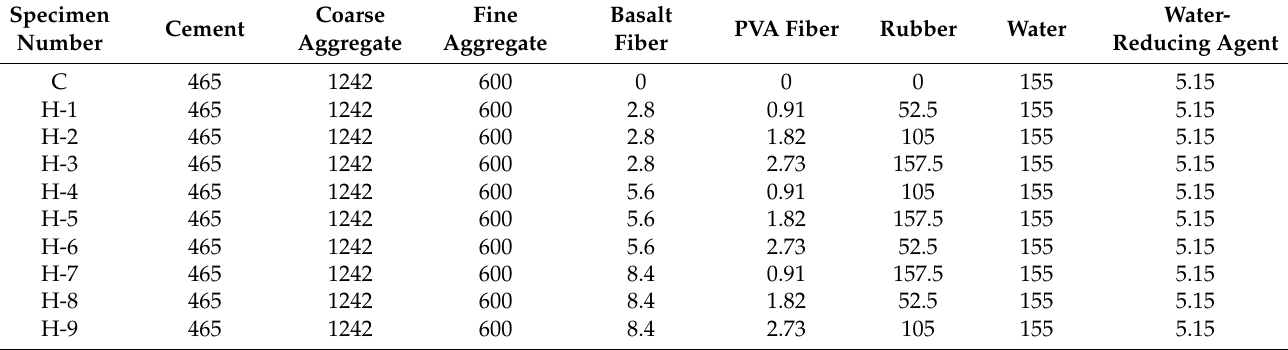
Table 3. Mix proportion of HFRC kg/m